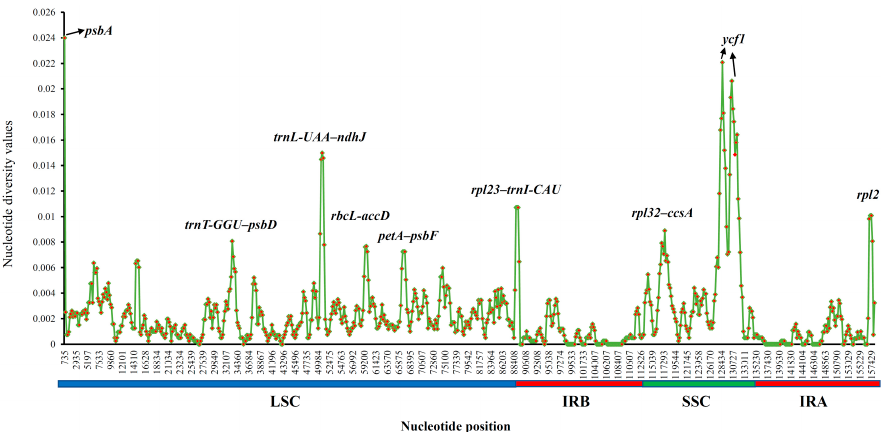
Figure 6. Complete cp genome sequence alignments of 10 Physalis species using the mVISTA pro- gram, with the cp genome of PMA as reference. The horizontal axis indicates the coordinates within the cp genomes. The vertical scale indicates the percentage identity within 50–100%.